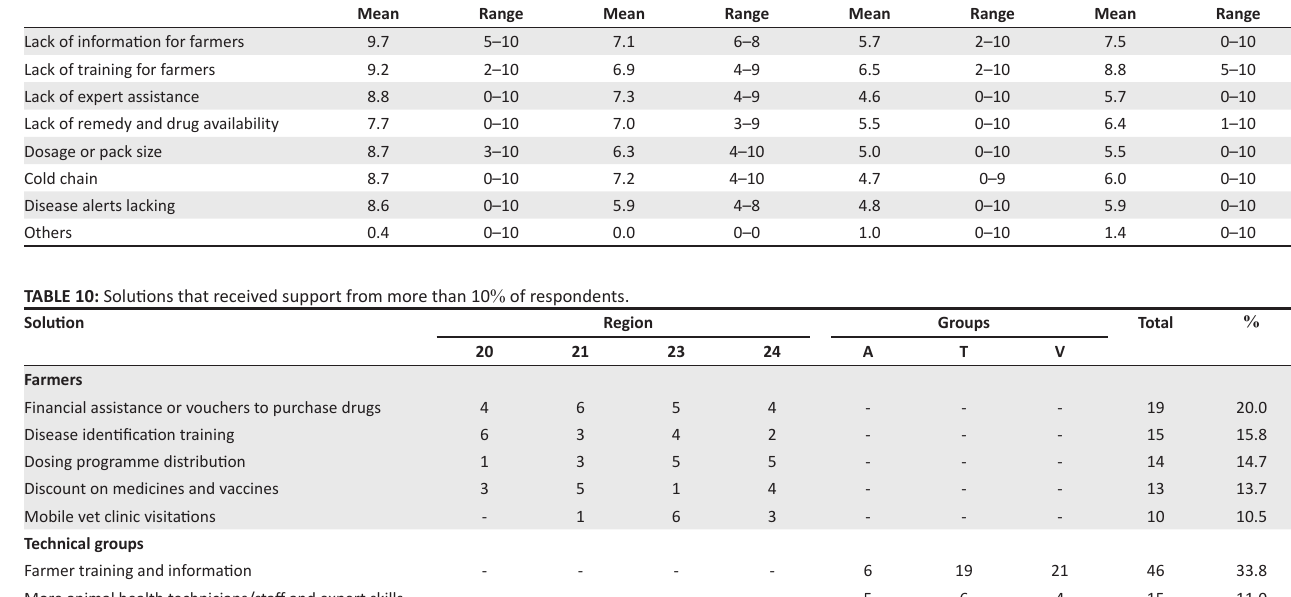
TABLE 9: Main problems in controlling diseases. Subcategory